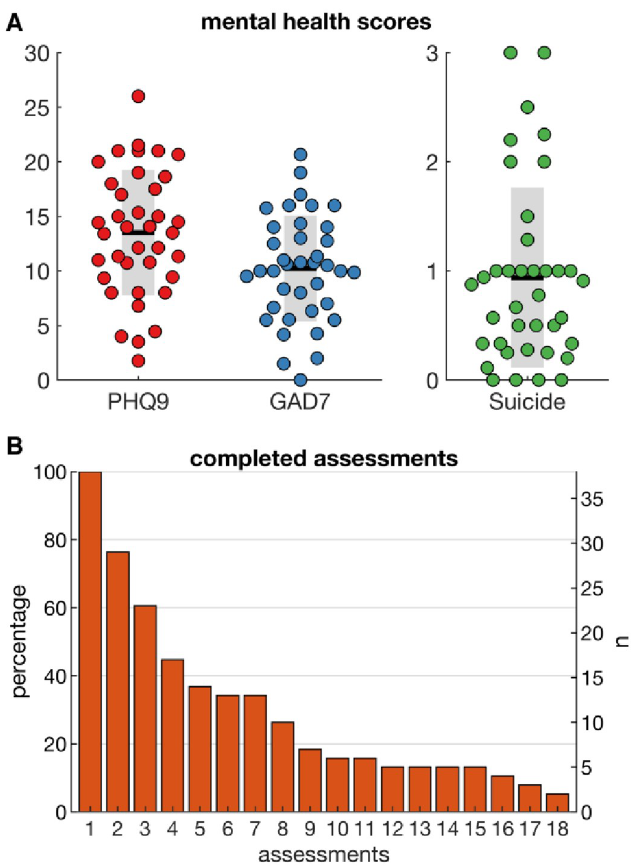
Fig 1. Characteristics of sample. A) Mental health scores (PHQ-9, GAD-7 and suicidal ideation) averaged across assessments and B) Number of mental health assessments completed by participants. Coloured dots show values of individual participants, the horizontal black line the group mean and the grey bars the